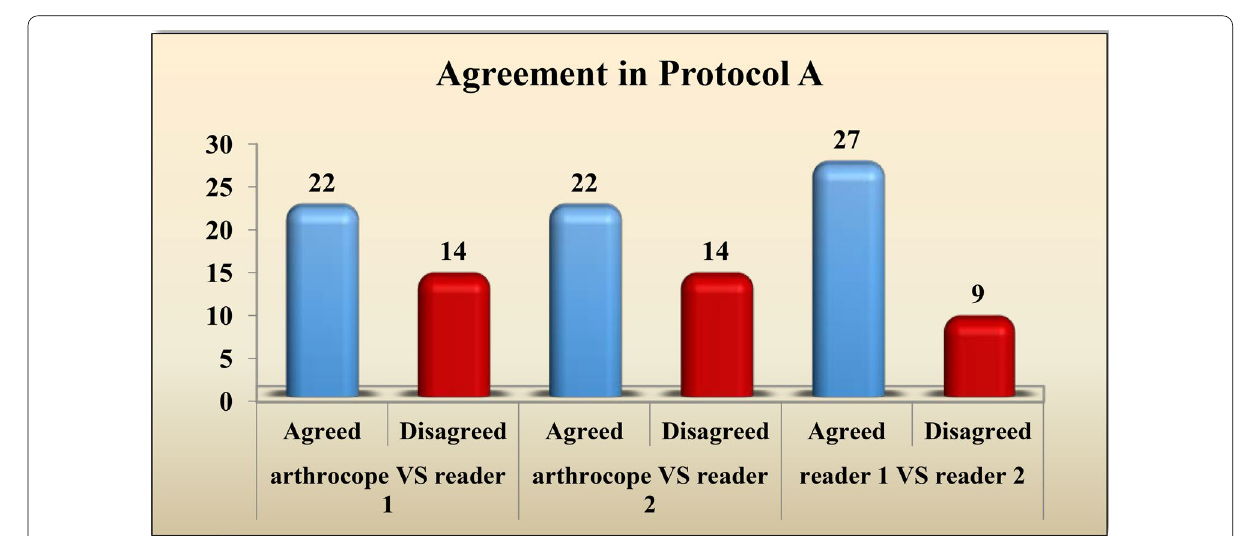
Fig. 9 The agreement between each reader and the arthroscopy, in addition to the interobserver agreement for protocol